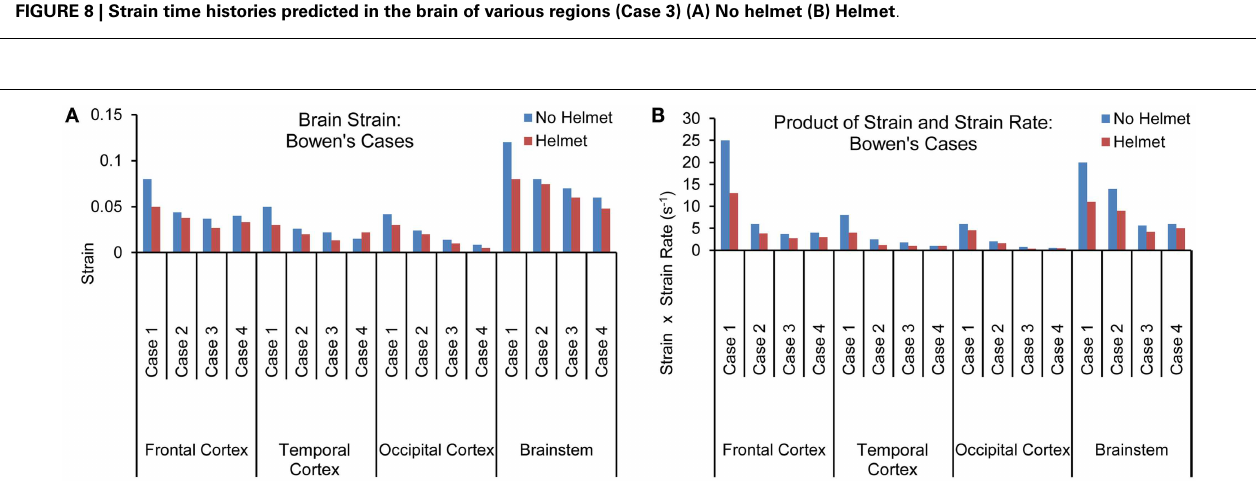
FIGURE 9 | (A) Peak magnitudes of maximum principal strain (B) Product of strain and strain rate comparison at various brain regions between the models with and without helmet as a result of blast loadings of various